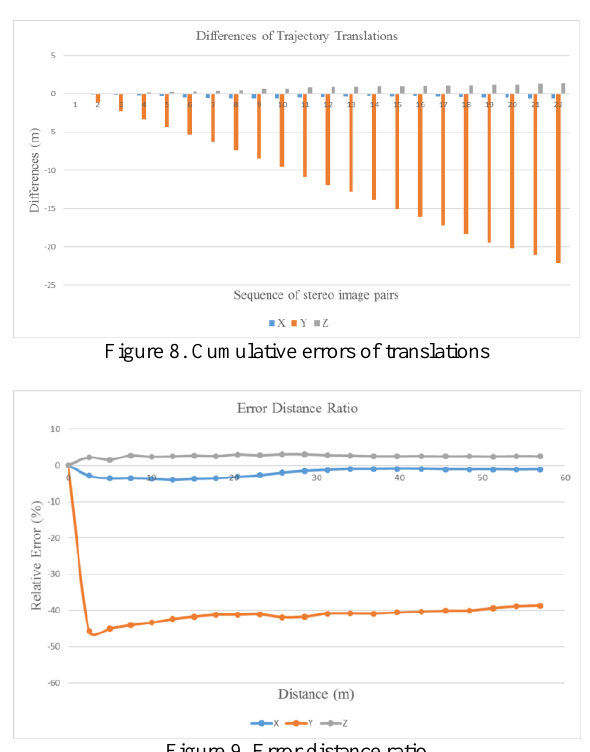
Figure 9. Error distance ratio